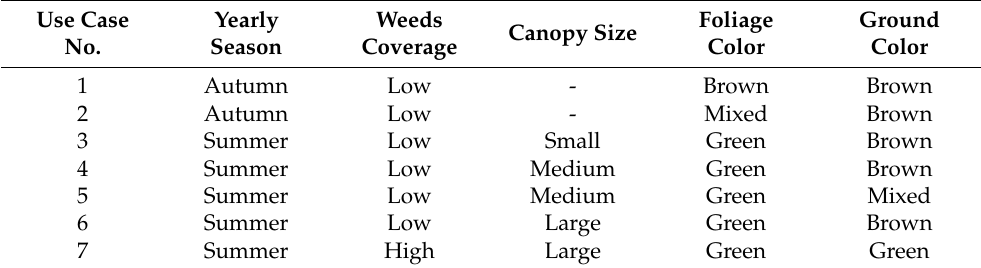
Table 1. Orchards’ characteristics and categorization into separate use cases.